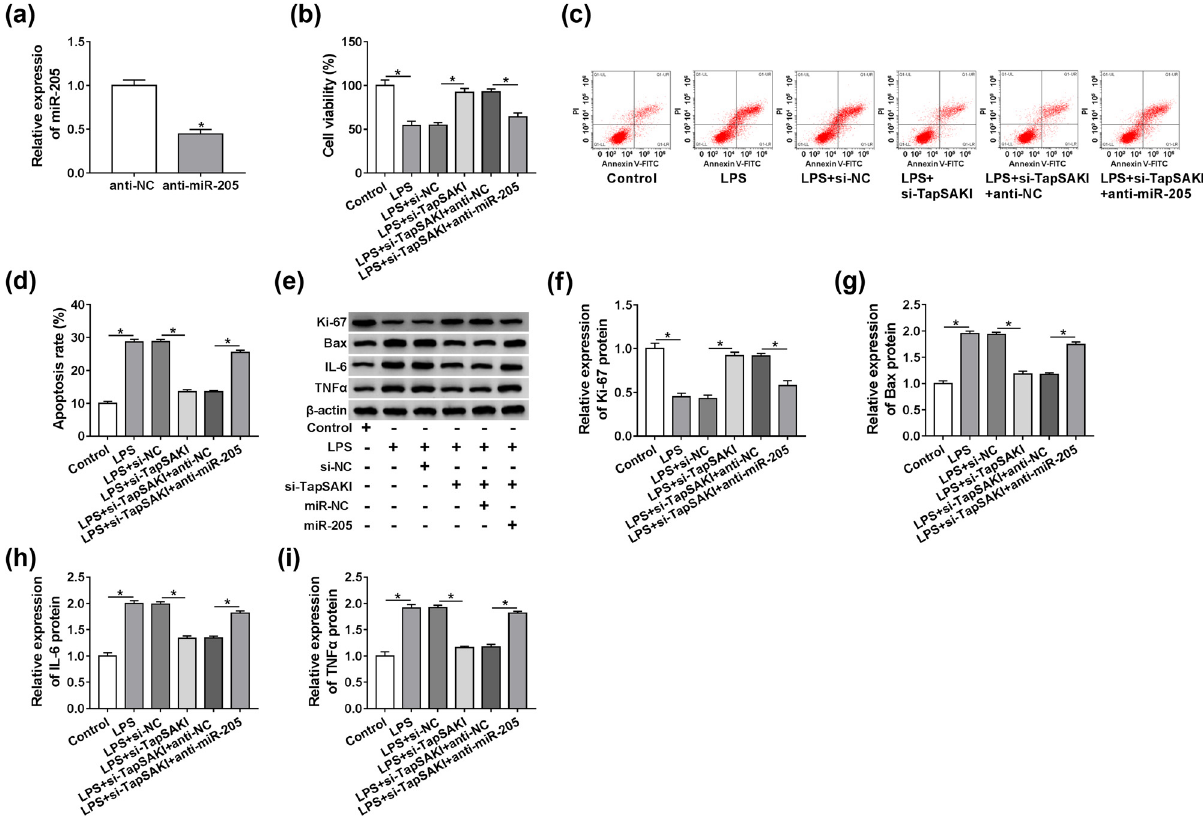
Figure 6: The alleviated e ff ect of TapSAKI depletion on LPS - induced HK - 2 cell damage was reversed by anti - miR - 205 cotransfection. ( a ) miR - 205 expression by qRT - PCR in HK - 2 cells transfected with anti - NC or anti - miR - 205. Cell viability by CCK - 8 assay ( b ) , cell apoptosis by fl ow cytometry ( c ) , Ki - 67, Bax, IL - 6, and TNF α levels by western blot ( d – h ) in HK - 2 cells transfected with or without si - NC, si - TapSAKI, si - TapSAKI + anti - NC, or si - TapSAKI + anti - miR - 205 before LPS treatment. * P < 0.05.